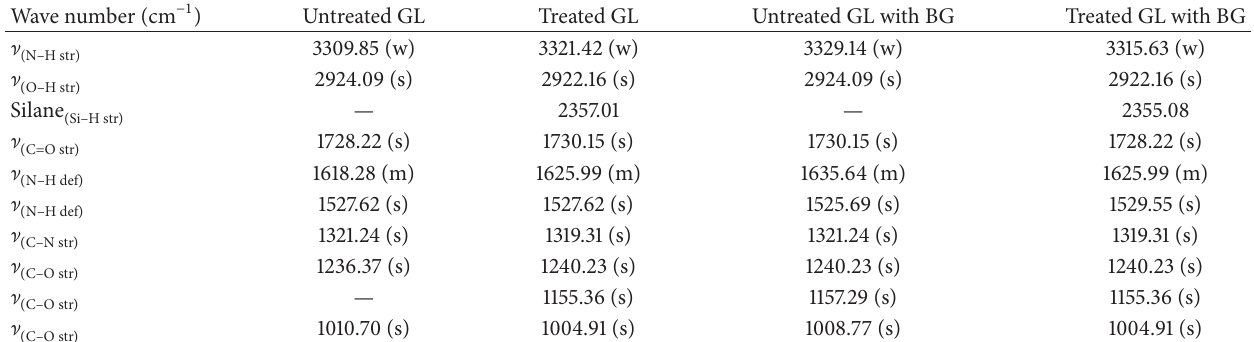
Table 4: Characteristic FTIR adsorption frequencies of functional groups of Guava leaves.